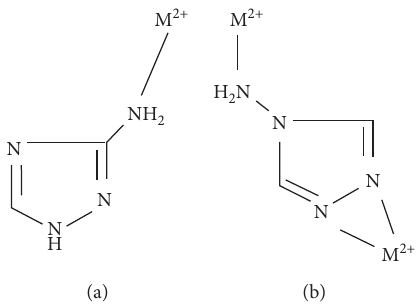
Figure 2: Schematic representation of the suggested coordinative characteristics for (a) 3amt and (b) 4amt adducts.